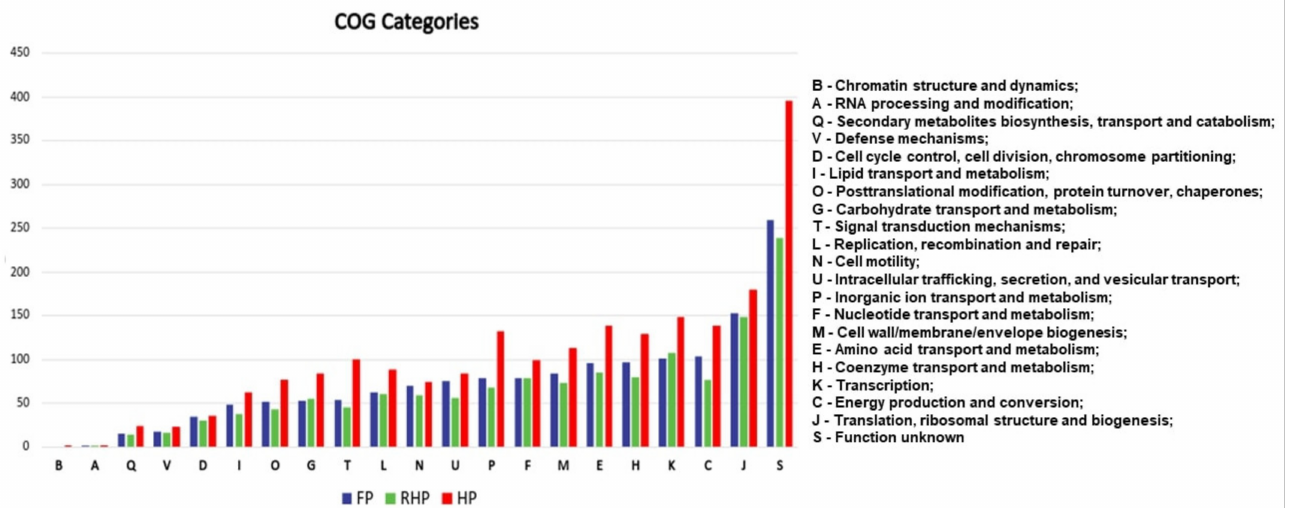
Figure 1. COG classifications made by eggNOG-mapper. Each category is represented by a letter, and each column corresponds to a group of pathogens. The HP group is red, green RHP, and blue